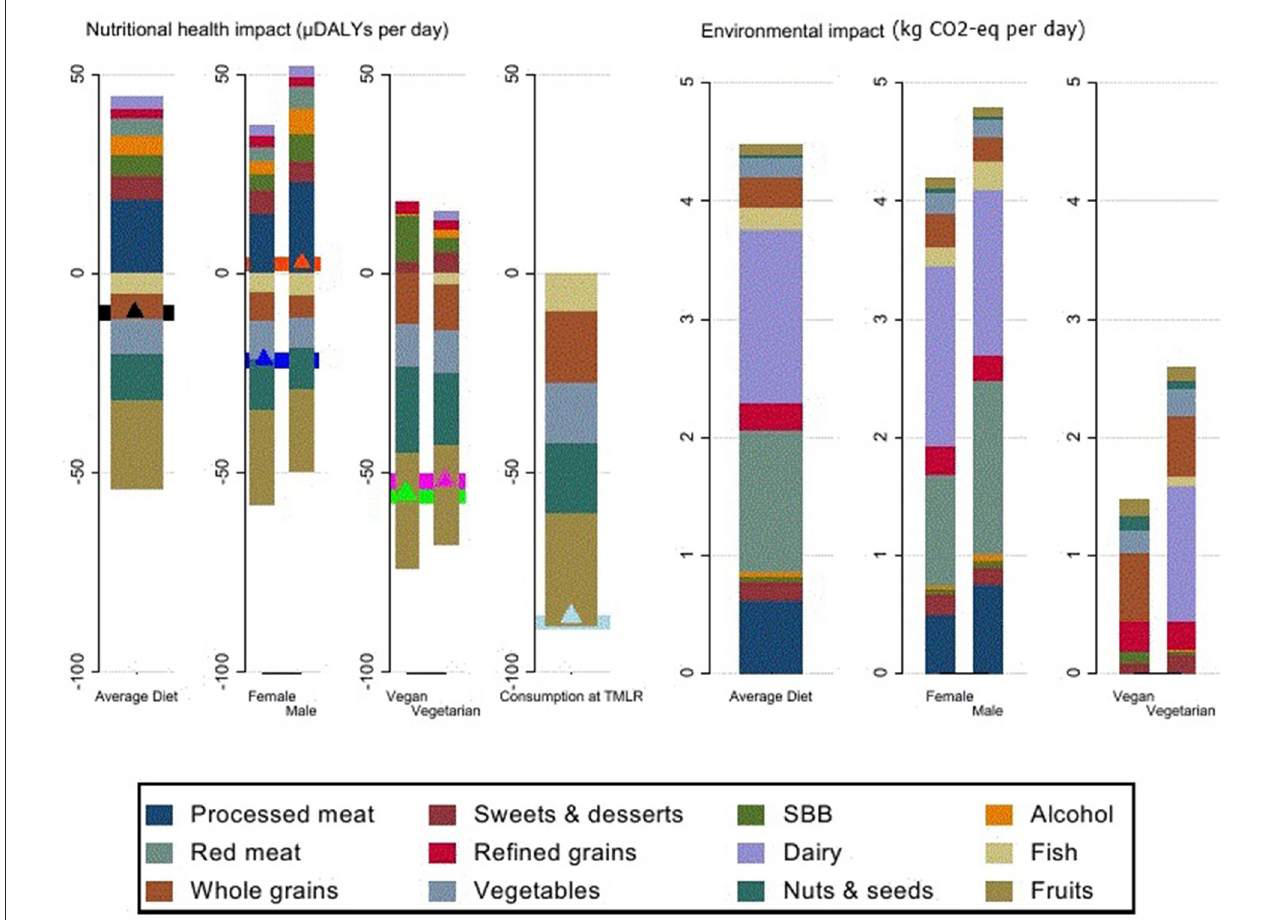
FIGURE 2 | Nutritional health impacts and carbon footprints for the consumption of 12 different foods for the overall average diet and the average vegan, vegetarian, female, and male diet. Vegetarian also includes pescetarians. Triangles in the nutritional health impact bars represent average values of the overall sample, and vegan, vegetarian, female, and male